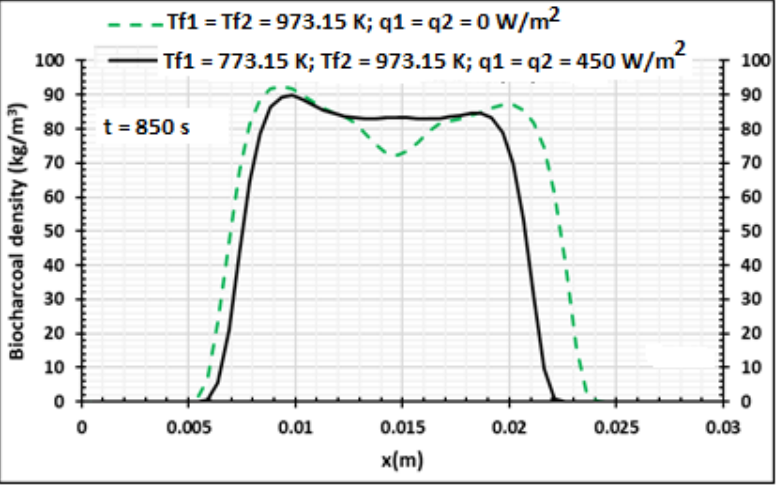
Figure 17. Density distribution. Production of the biocharcoal using samples of 30 mm thickness, ρ bo = 700 kg/m 3 . Influence of the contact temperature and heat flux density, t = 850 s.